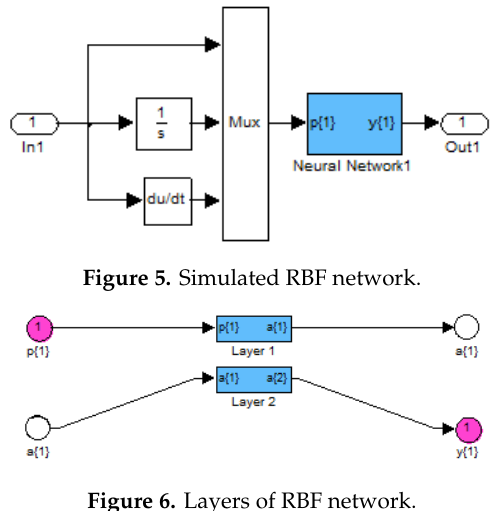
Figure 6. Layers of RBF network.